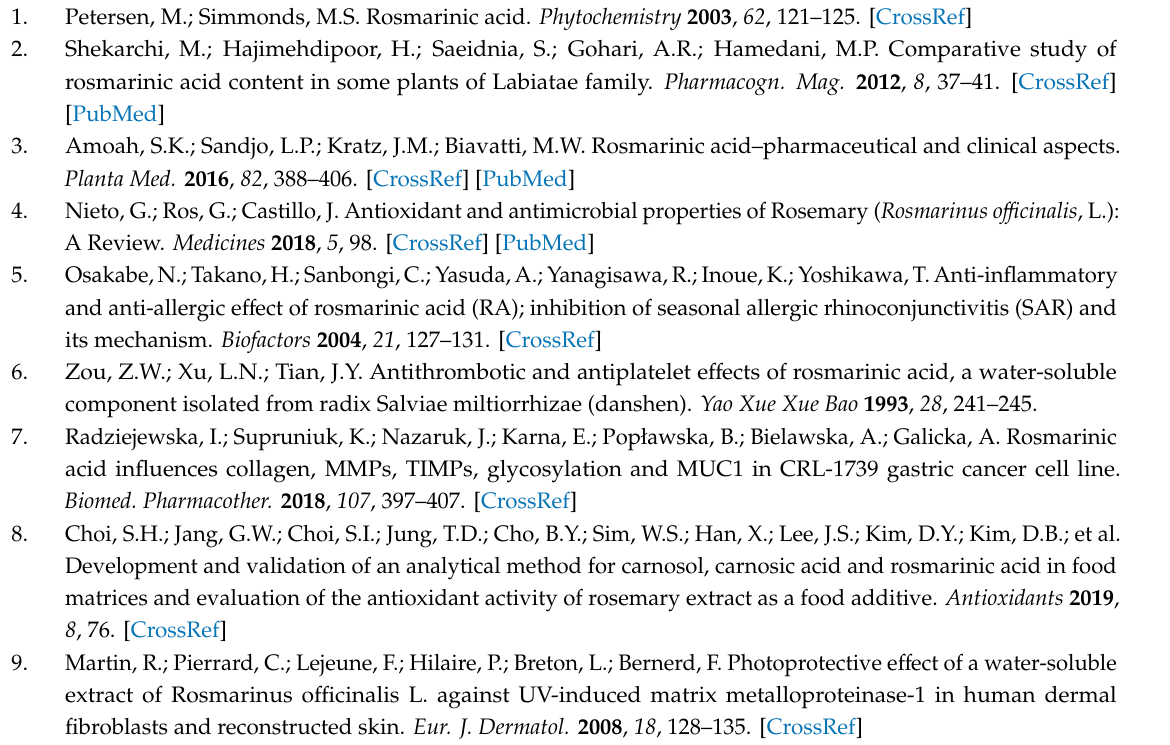
Table S1: The ratio of the concentrations of parabens (methylparaben—MP and propylparaben—PP) in the selected cosmetic and hygiene products. Table S2: Estimation of the main and interactive e ff ects of parabens (methylparaben—MP and propylparaben—PP) and rosmarinic acid (RA) on the expression of COL1A1 and COL1A2 genes coding collagen I, and COL3A1 coding collagen III in the human skin fibroblasts. Table S3: Estimation of the main and interactive e ff ects of parabens (methylparaben—MP and propylparaben—PP) and rosmarinic acid (RA) on the expression of collagen triple helix repeat containing-1 (CTHRC1) and heat shock protein, 47 kDa (HSP47) at the mRNA and protein levels in the human skin fibroblasts. Table S4: Estimation of the main and interactive e ff ects of parabens (methylparaben—MP and propylparaben—PP) and rosmarinic acid (RA) on the expression of matrix metalloproteinases (MMP-1 and MMP-2) at the mRNA and protein levels in the human skin fibroblasts. Table S5: Estimation of the main and interactive e ff ects of parabens (methylparaben—MP and propylparaben—PP) and rosmarinic acid (RA) on the activity of matrix metalloproteinases (MMP-1 and MMP-2) in the human skin fibroblasts. Table S6: Estimation of the main and interactive e ff ects of parabens (methylparaben—MP and propylparaben—PP) and rosmarinic acid (RA) on the expression of membrane type-1 matrix metalloproteinase (MT1-MMP) at the mRNA and protein levels in the human skin fibroblasts. Table S7: Estimation of the main and interactive e ff ects of parabens (methylparaben—MP and propylparaben—PP) and rosmarinic acid (RA) on the expression of tissue inhibitors of matrix metalloproteinases (TIMP-1 and TIMP-2) at the mRNA and protein levels in the human skin fibroblasts. Table S8: Estimation of the main and interactive e ff ects of parabens (methylparaben—MP and propylparaben—PP) and rosmarinic acid (RA) on the expression of B-cell lymphoma-extra large antiapoptotic protein (Bcl-xL) and BCL2-associated X protein (Bax) at the mRNA and protein levels in the human skin fibroblasts. Table S9: Estimation of the main and interactive e ff ects of parabens (methylparaben—MP and propylparaben—PP) and rosmarinic acid (RA) on the expression of cleaved caspase-3 in the human skin